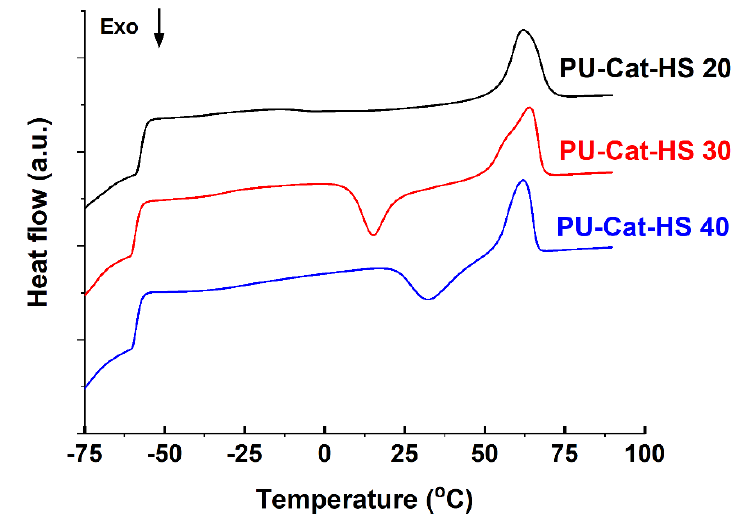
Figure 4. DSC thermograms of segmented polyurethanes bearing catecholic motifs into the hard